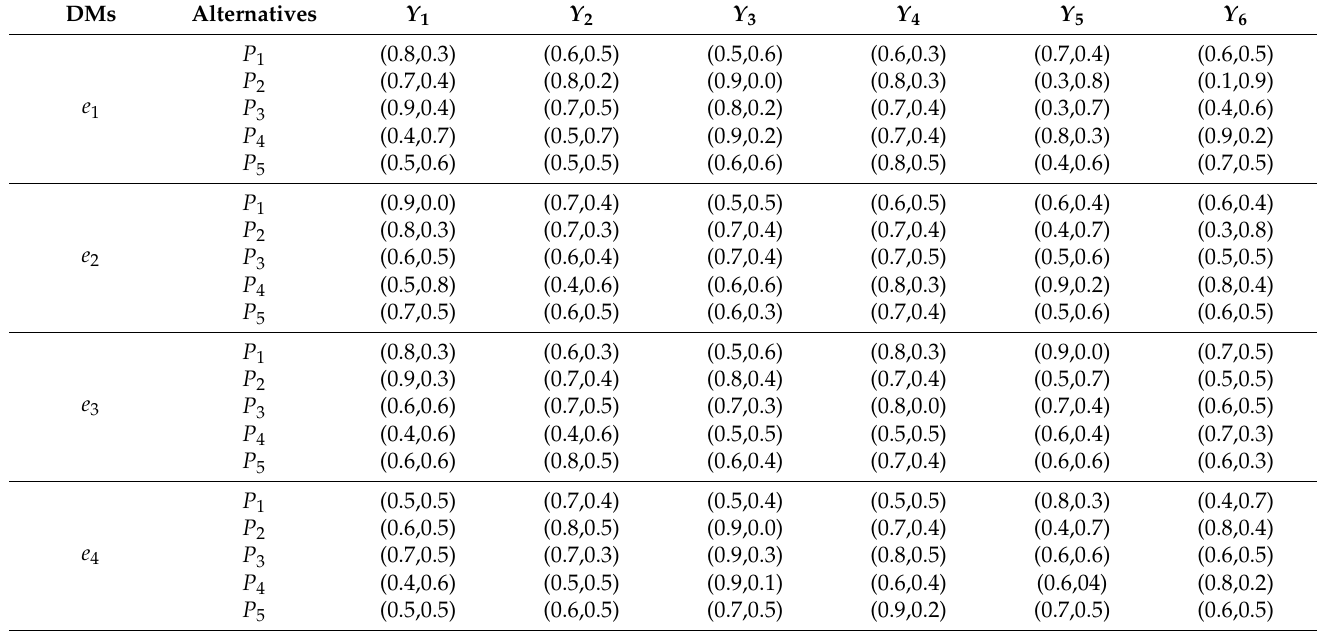
Table 4. Normalized individual